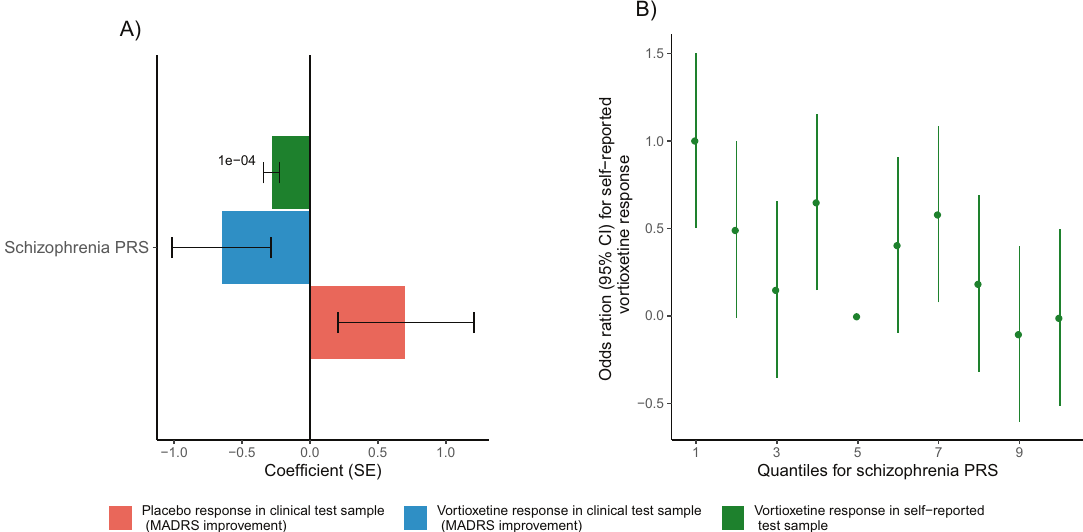
Fig. 3 Schizophrenia PRS association with vortioxetine response. A Bar plot showing the coef fi cients of schizophrenia PRS association with placebo and vortioxetine response in the clinical and self-reported test sample. B Odds ratios for vortioxetine response in the self-reported sample for quantiles of schizophrenia PRS.